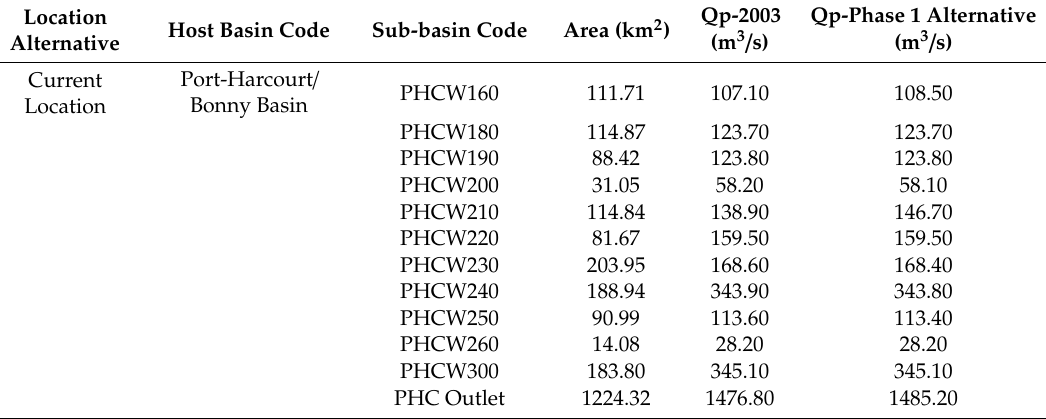
Table 7. Modelled result of peak flow responses to Current Project Alternative in Port-Harcourt Basin. PHC = Port-Harcourt Basins; W = watershed; Qp = Peak discharge; Qp-2003 = Peak discharge based on year 2003 LULC condition; Qp-Phase 1 Alternative = Peak discharge based on Phase 1 alternative LULC